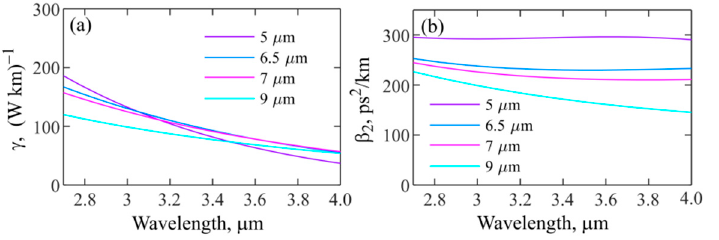
Figure 6. Calculated nonlinear Kerr coefficients ( a ) and quadratic dispersion coefficients ( b ) for step-index arsenic sulfide glass fibers with NA = 0.3 and different core diameters.